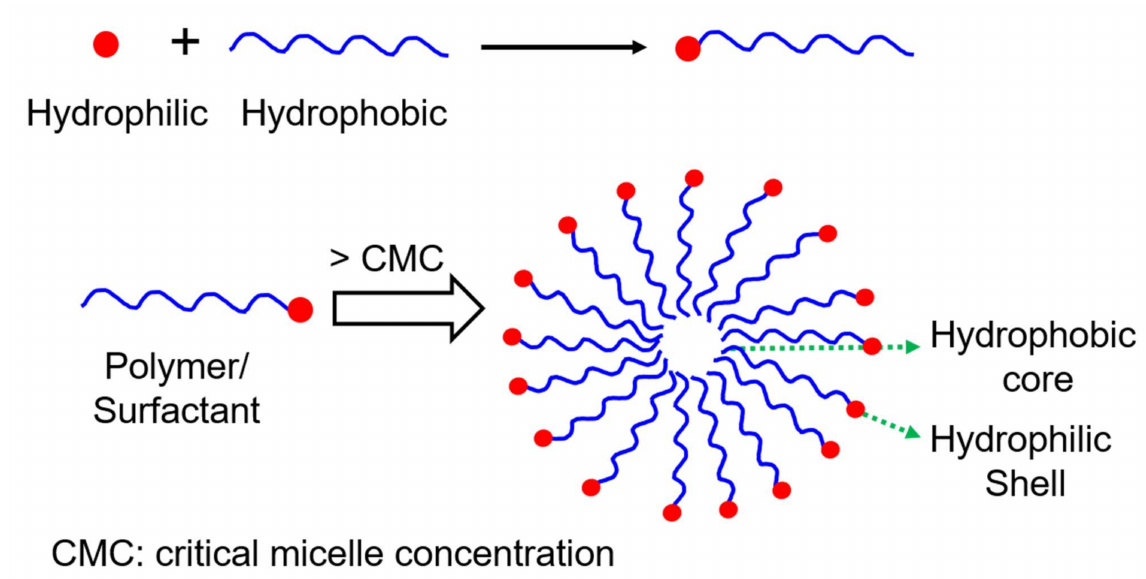
Scheme 1. Illustration of the self-assembly of the polymer or surfactant into a spherical